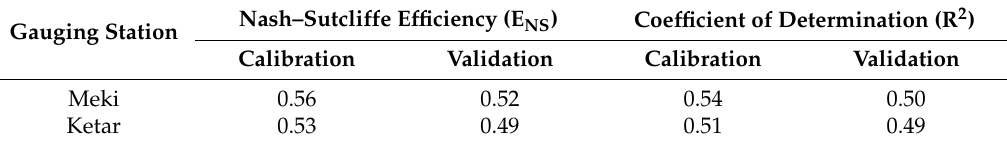
Table 4. Model performance efficiency during calibration and validation